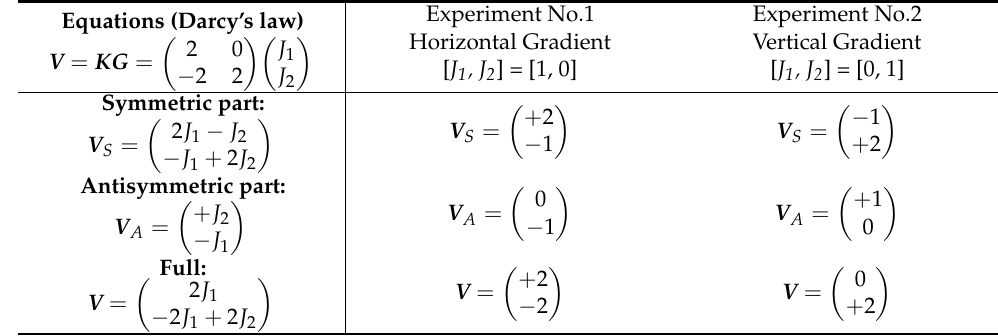
Table 1. Antisymmetry effects on flow direction for a given hydraulic gradient vector J